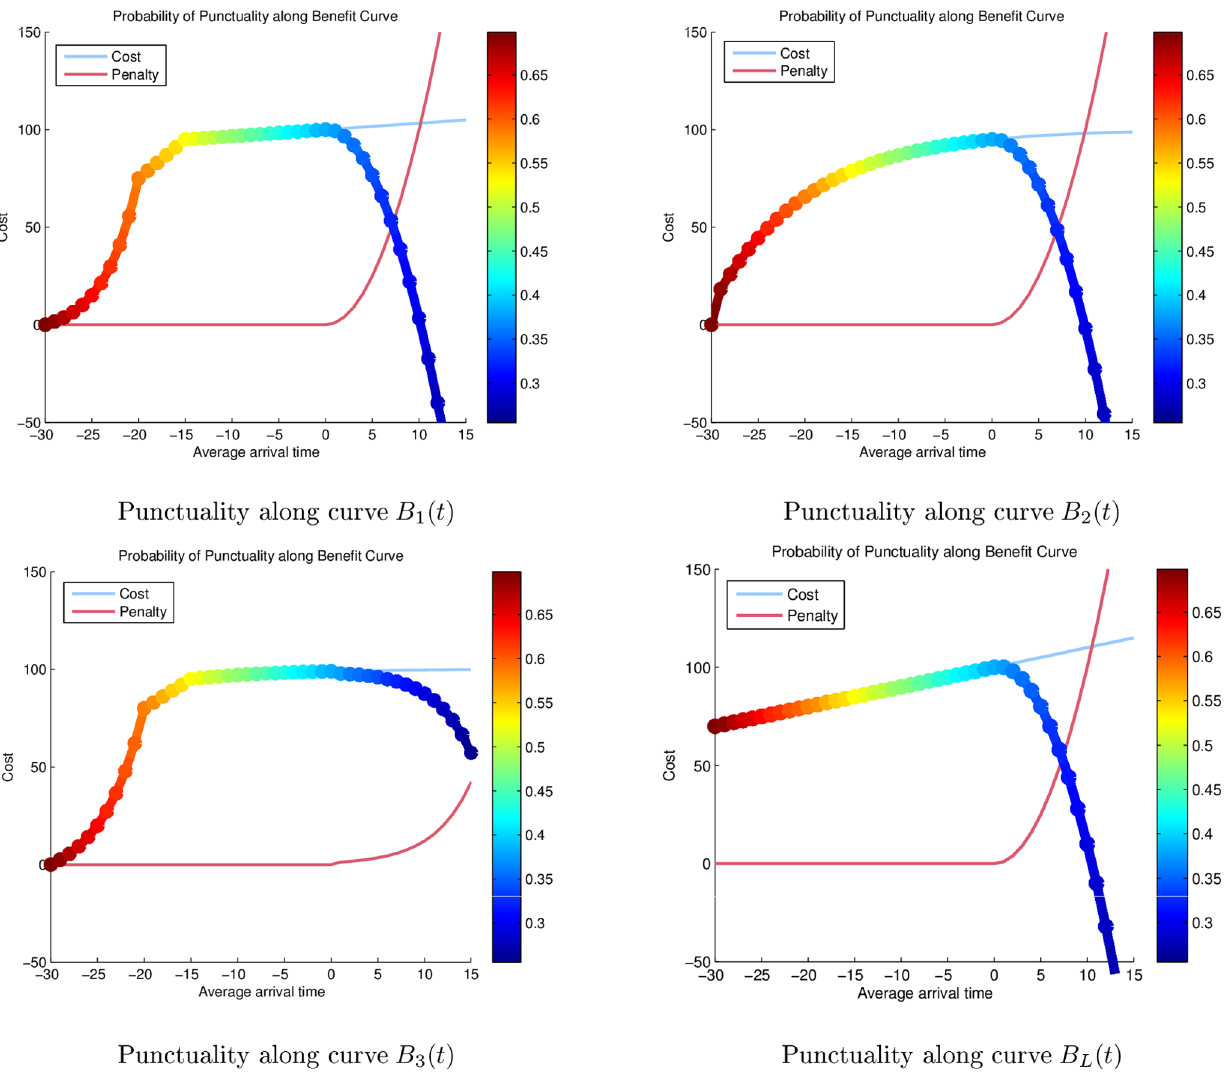
Fig 5. Punctuality vs cost-benefit and penalty function.